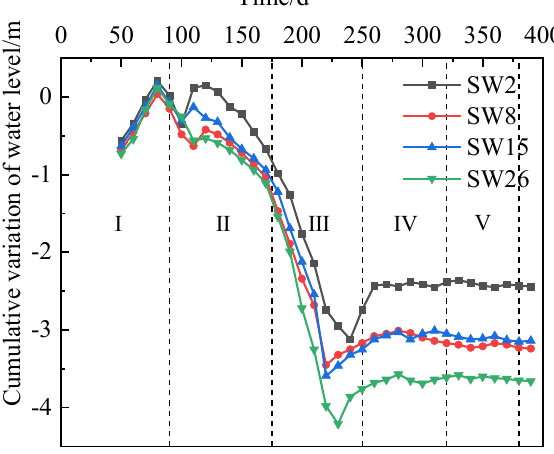
Figure 9. Deep horizontal displacement curve.